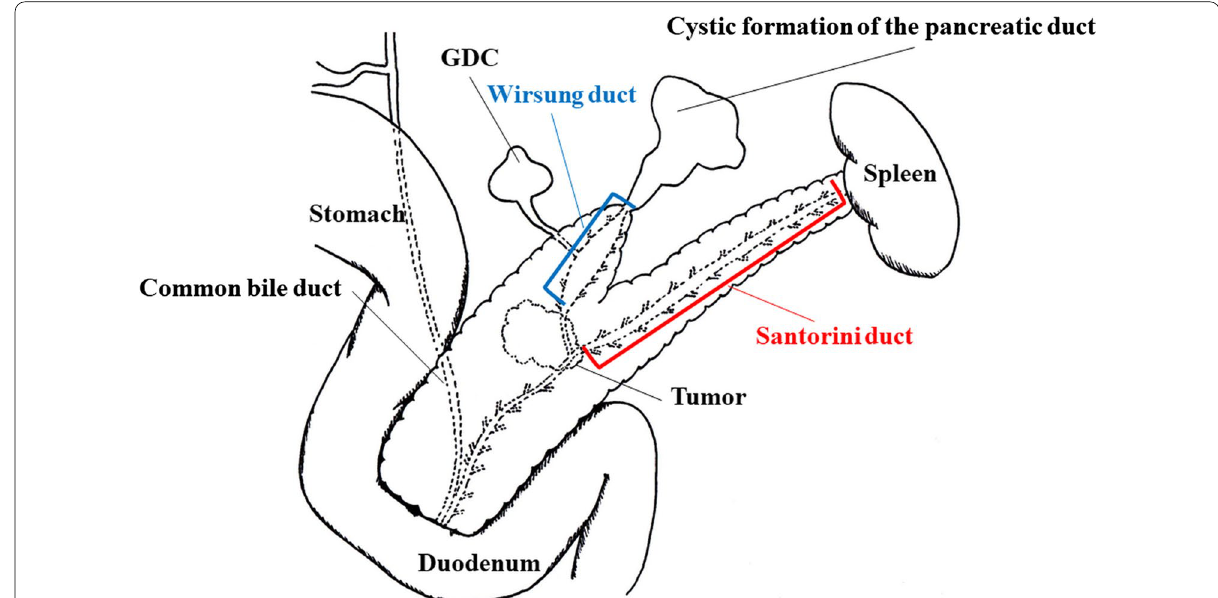
Fig. 6 The schema of anatomical features in this case. In this case, PDAC occurred at the junction of pancreatic ducts of PD, and the disruption by PDAC induced the GDC dilatation and cystic formation of the pancreatic